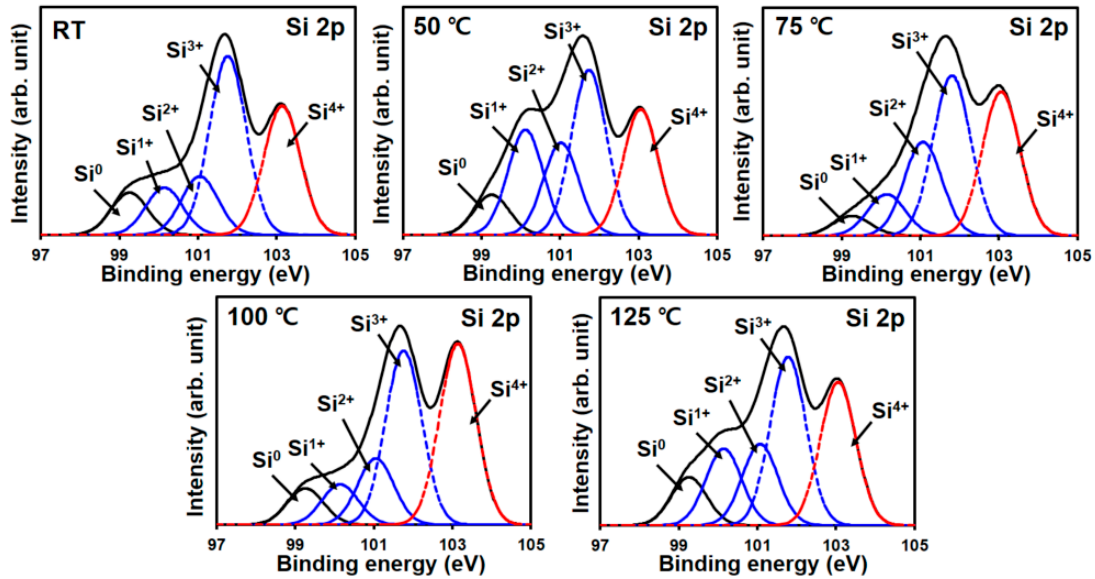
Figure 3. Si 2p spectra of SiO y formed at the V 2 O 5 − x (15 nm)/Si interfaces at each of the different temperatures.